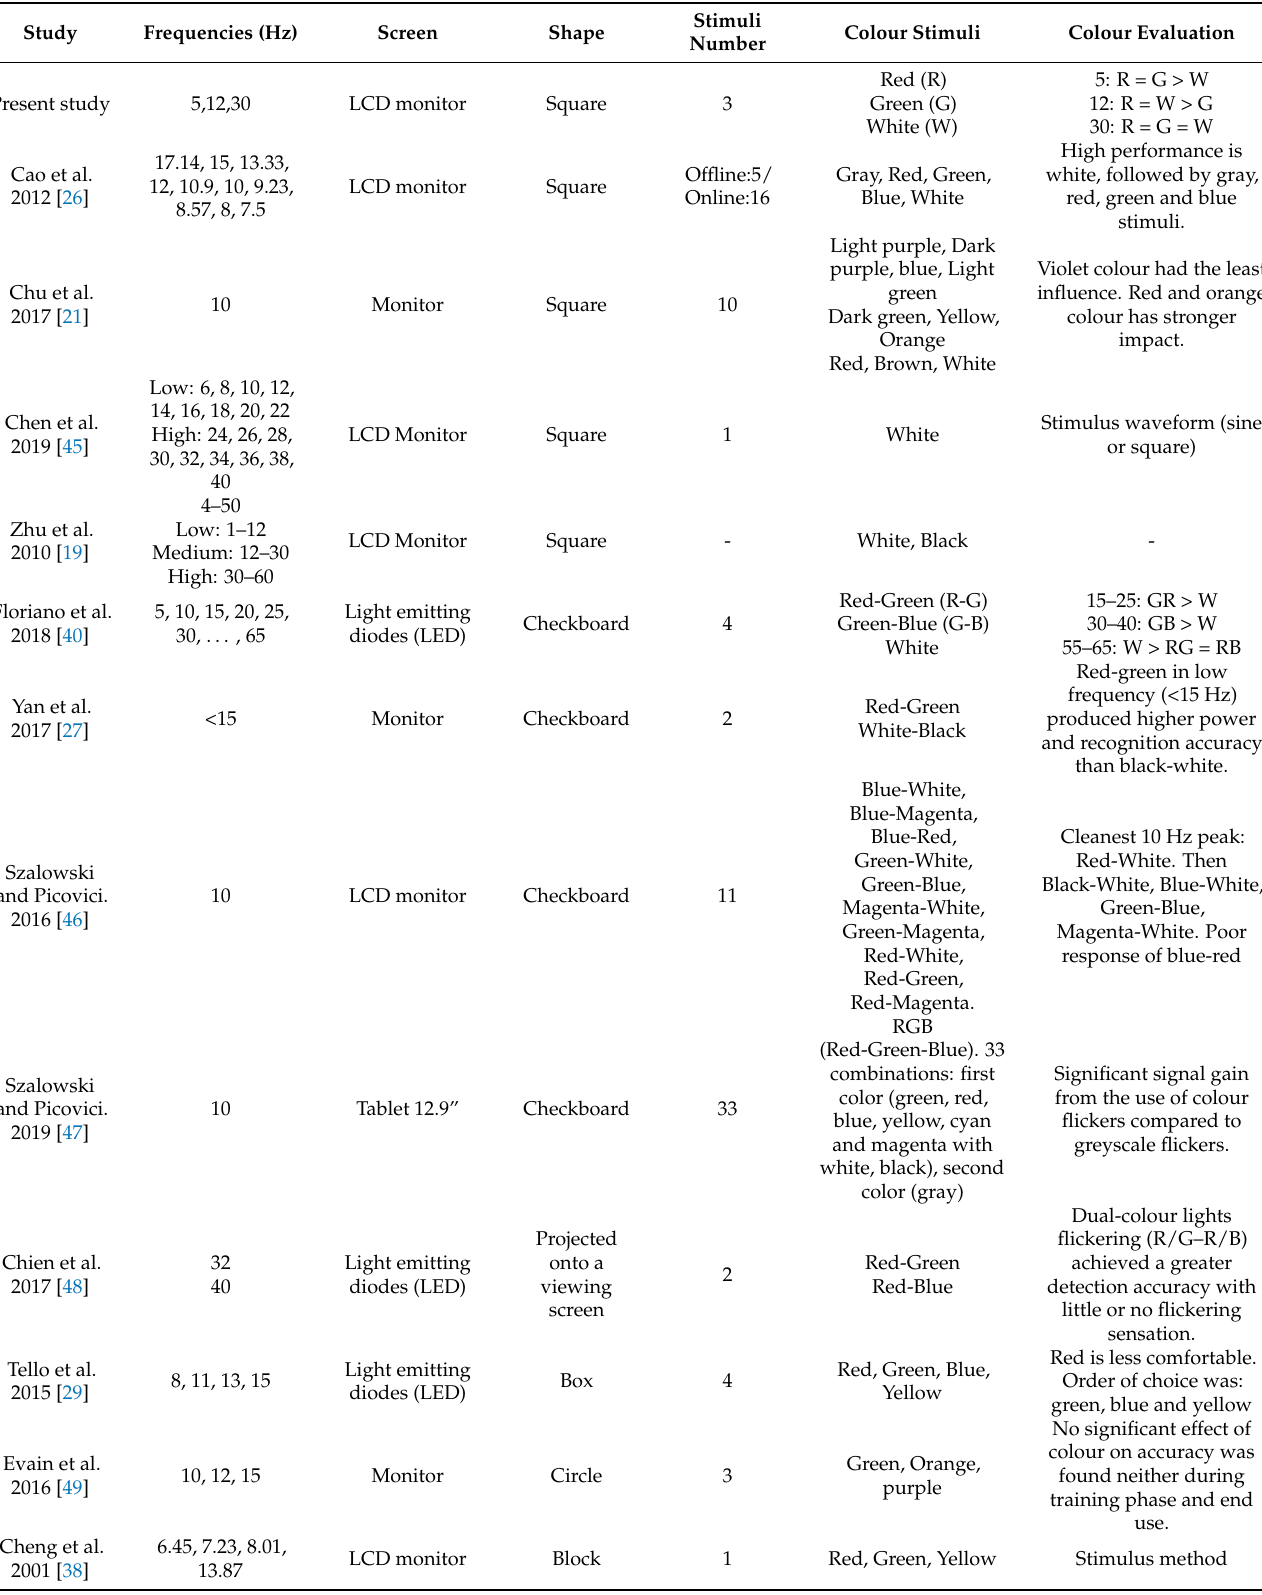
Table 9. Characteristics of stimuli.